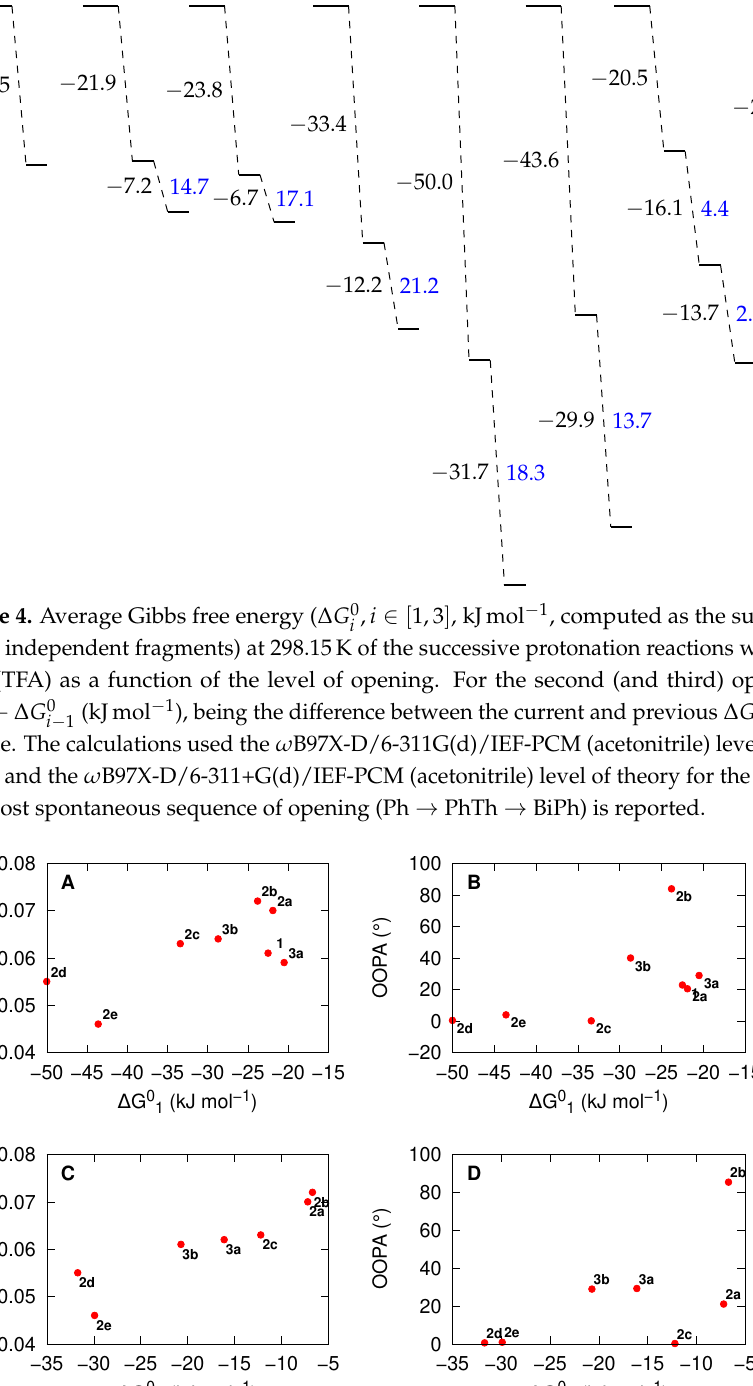
, kJmol − 1 , panels A and 1